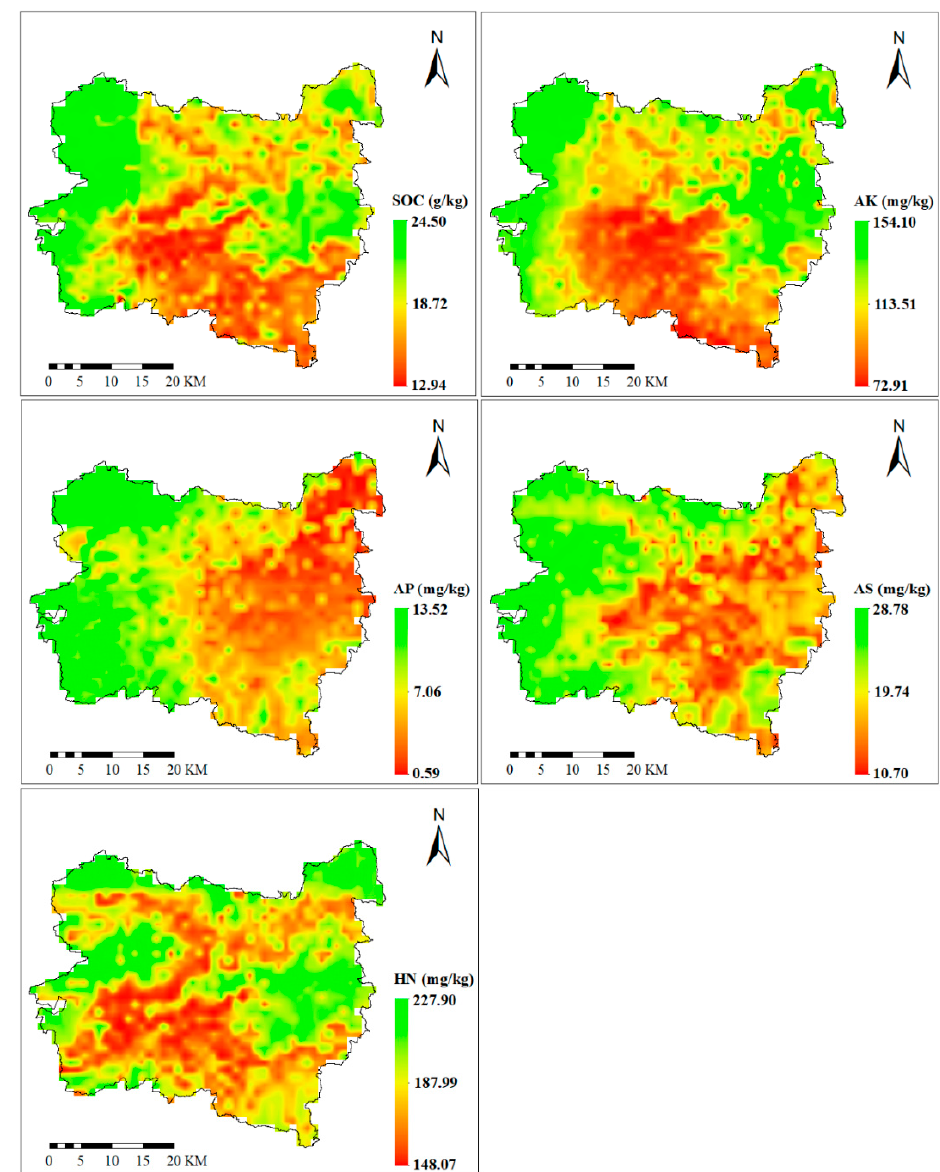
Figure 5. Mapping spatial distribution maps of macronutrients in soils. (SOC indicates soil organic carbon, SK indicates soil available potassium, AP indicates soil available phosphorus, AS indicates available sulfur, HN indicates soil hydrolyzed nitrogen).